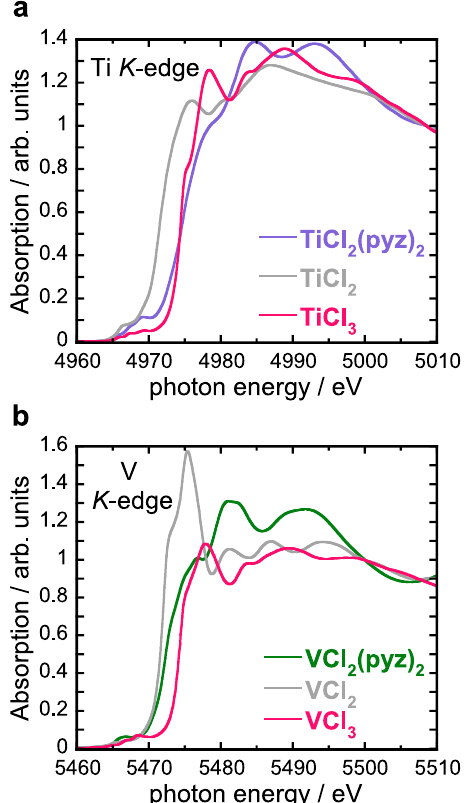
Fig.2|X-rayabsorptionspectroscopy.a Ti K -edgeand b V K -edgeXANESspectra of polycrystalline TiCl 2 (pyz) 2 , VCl 2 (pyz) 2 and the reference compounds recorded atroom temperature.The spectrawerenormalizedto zero beforethe edge and to unity far above the edge.